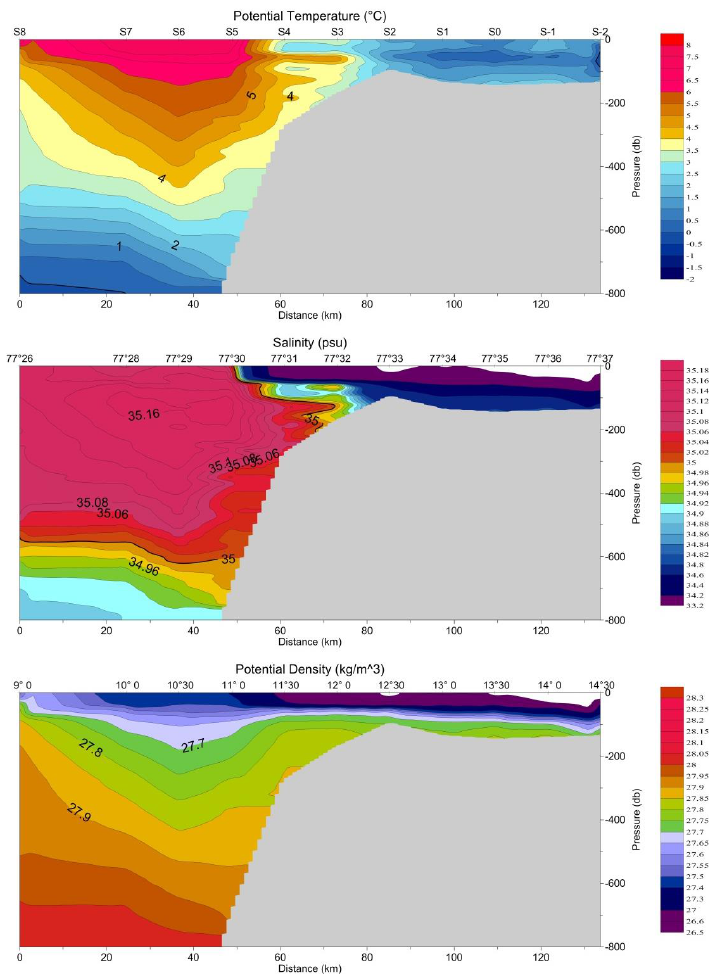
Figure 13. Section across the core of the WSC and the Polar Front over western Spitsbergen shelf. (a) Temperature, (b) salinity, and (c) potential density. Section “S”, R/V Oceania , summer 2005.